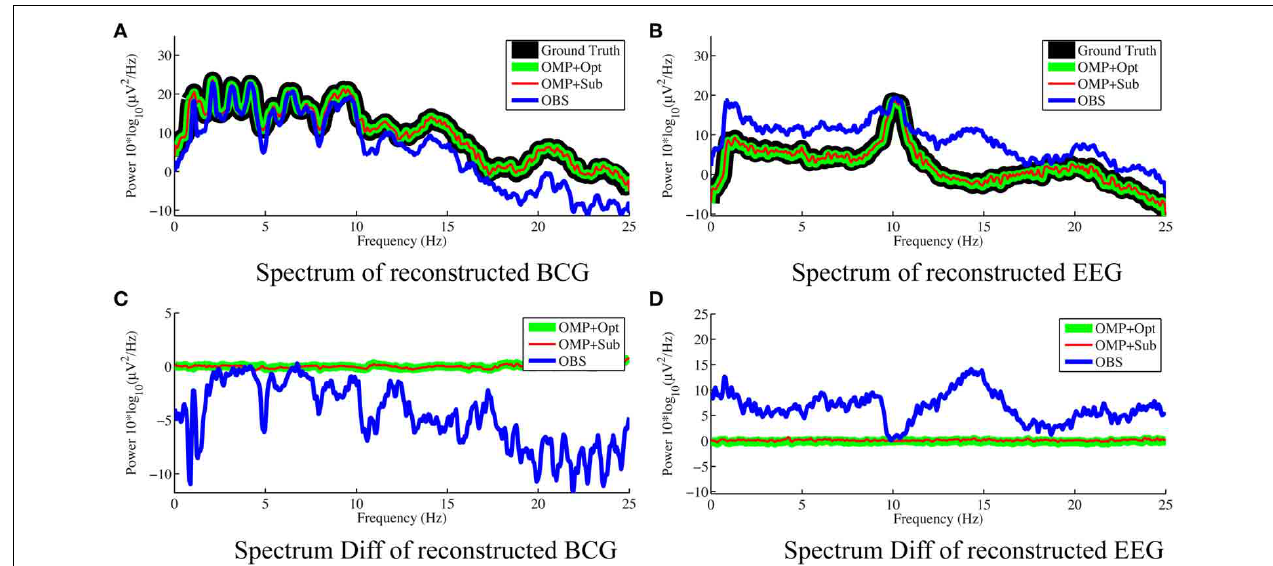
FIGURE 6 | Frequency spectra of reconstructed BCG (A) and EEG (B) from channel 118 with 0.05Hz frequency resolution. The OMP related approaches reconstruct signals that are so close to the ground truth that their